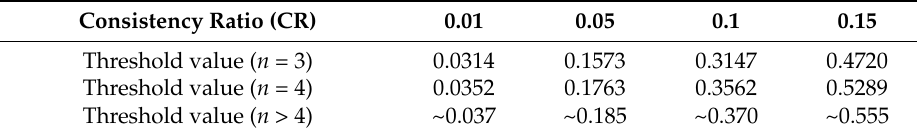
Table 1. Geometric inconsistency approximated